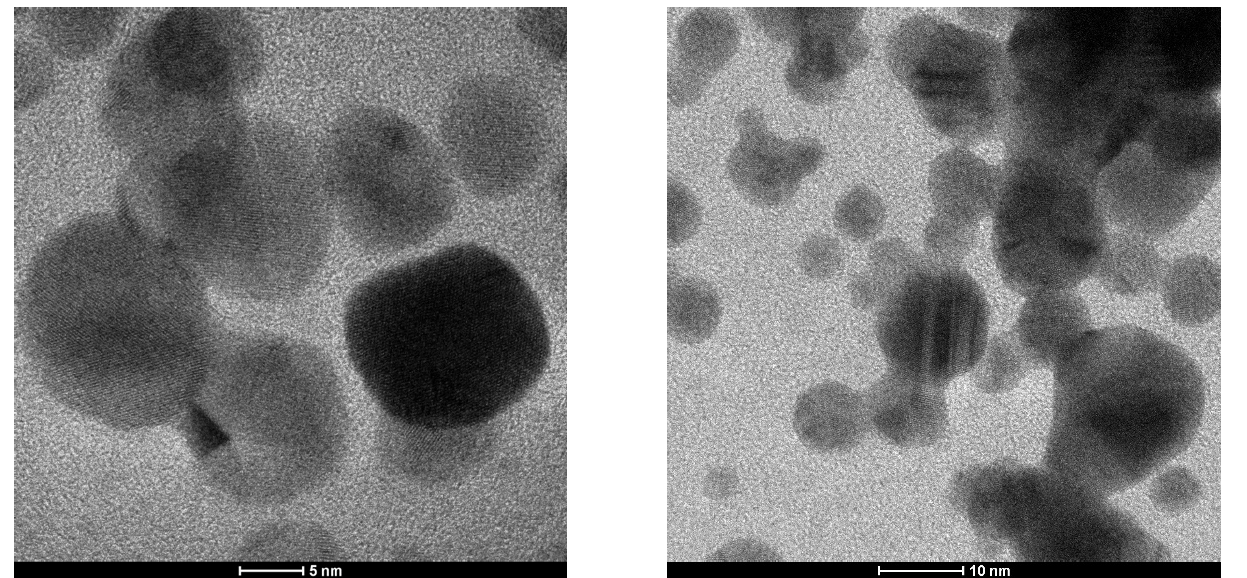
Figure 6. TEM image of Fe 3 O 4 @Chitosan-AgNPs (0.4).